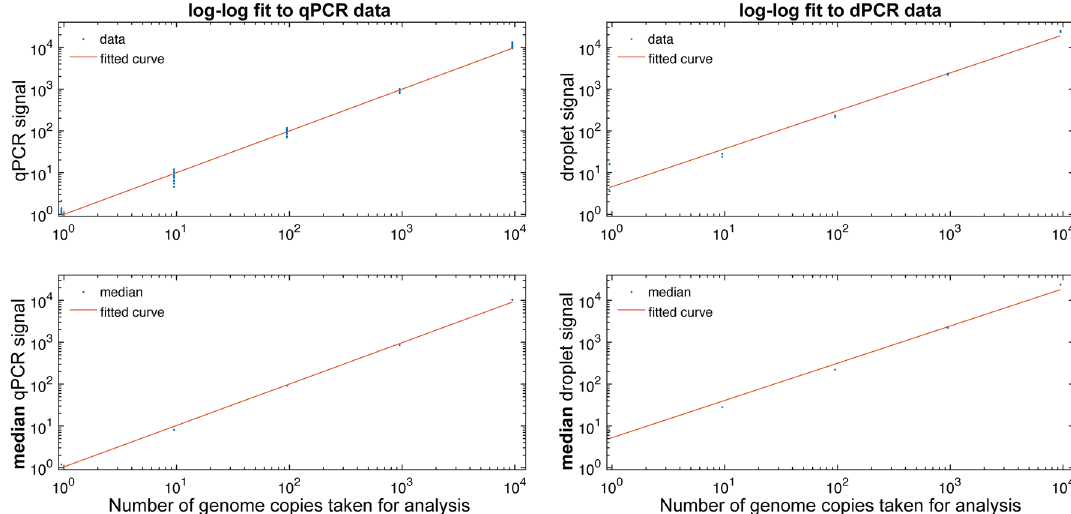
Figure 4. Quantitation of SARS-CoV-2 RNA N1 by RT-qPCR and RT-dPCR. Data were generated from technical replicates along a 1:10 dilution series of genomic RNA positive control material. Replicate data (top panels) and the replicate mean (bottom panels) along the dilution series are shown with a weighted fit to a straight line. The equations for the log–log RT-qPCR data: y = 1.0x − 5.3E−05 (r 2 = 1.0), fitted RT-qPCR median: y = 1.0x + 2.3E−02 (r 2 = 1.0), fitted RT-dPCR data: y = 0.9x + 0.7 (r 2 = 1.0), fitted RT-dPCR median: y = 0.9x + 0.7 (r 2 =